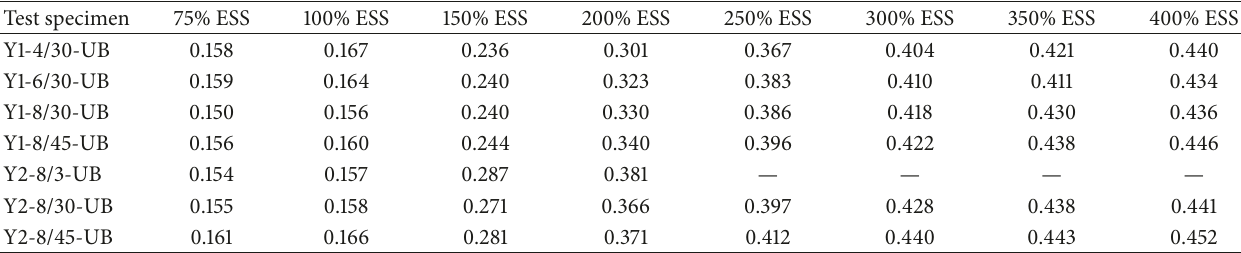
Table 3: Equivalent damping